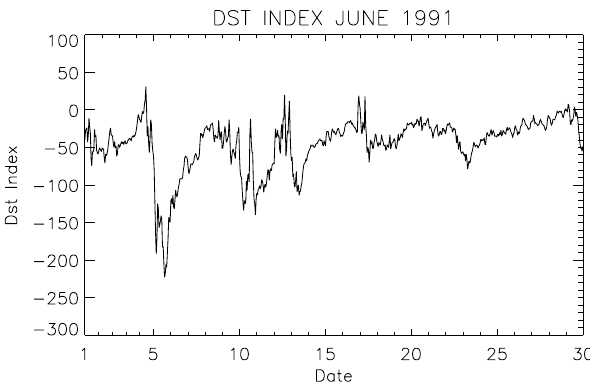
Fig. 4. The Dst index for the month of June 1991. Almost the en- tire month of June is either geomagnetically disturbed, or recover- ing from geomagnetically disturbed conditions. A particularly large disturbance occurred on 4